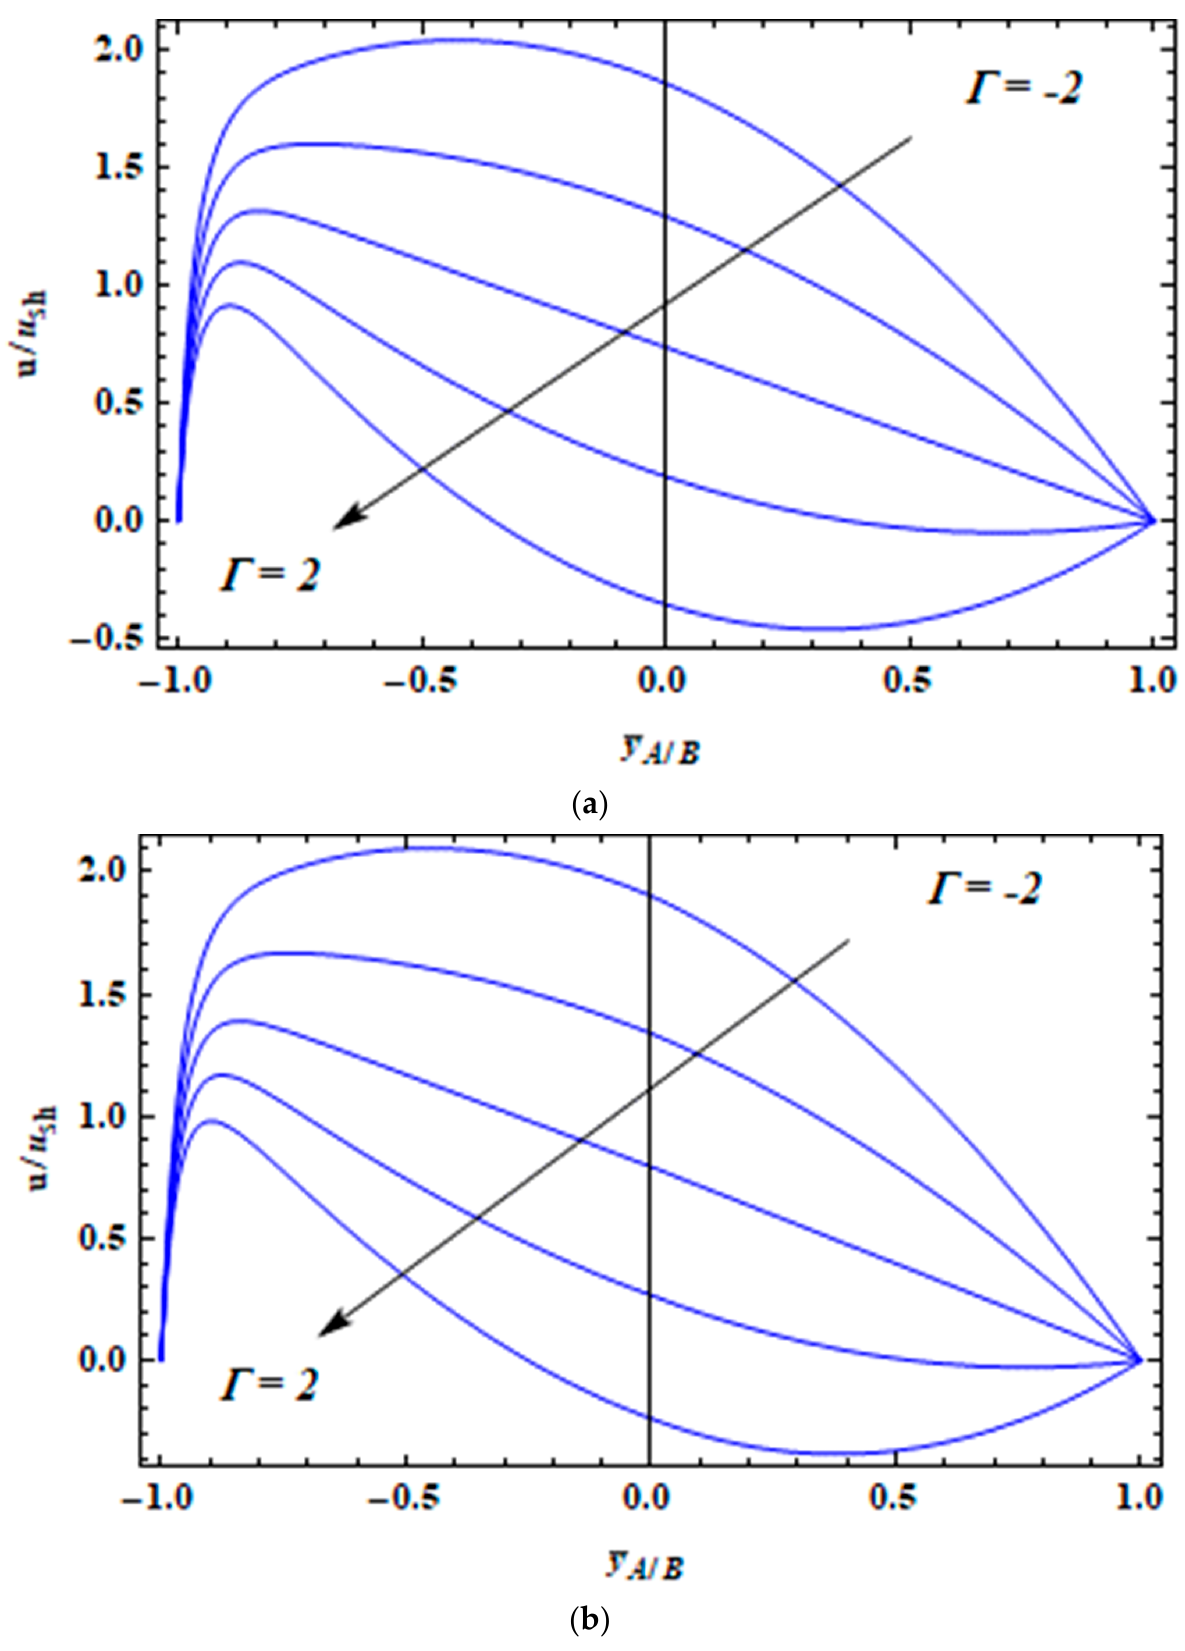
(cid:2869) = ; ( b ) 𝛽 = 1; 𝑅 = 20; 𝑅 (cid:3002) (cid:2870)